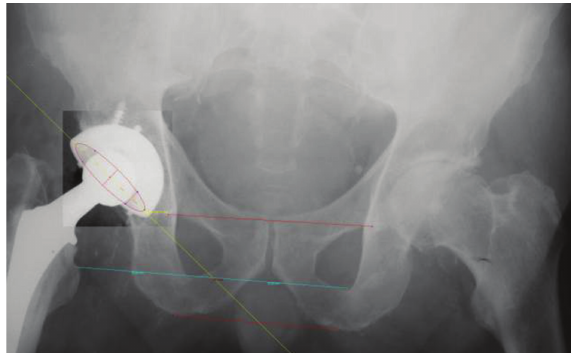
Figure 3: Digitalized representation of an AP radiograph centered over the pelvis as well as the determination of the inclination and anteversion using the software Imagika 1.50. To determine the anteversion, the ratio of the major and minor ellipses was used, which corresponds to the dark portion of the cup using the method of Ackland. The inclination of the cup was determined by measuring the angle between a line joining the ischial tuberosities or the teardrops and a line through the long axis of the ellipse.